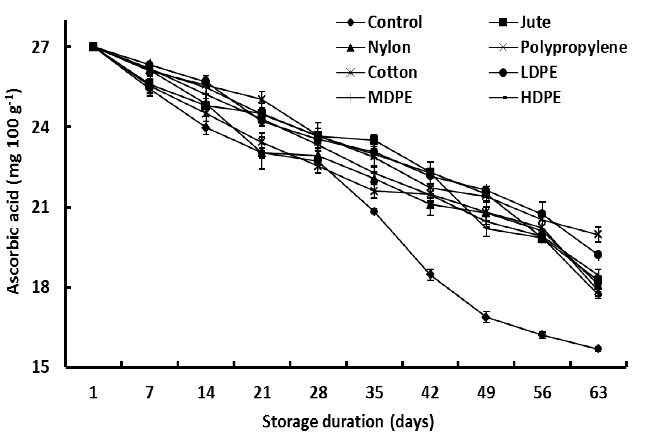
Fig. 3: Ascorbic acid content in potato tubers stored using different pa- ckaging materials was highest by the end of the storage period in polypropylene packages. Vertical bars show ±SE of means (n-3). Interaction between storage intervals and packaging materials was significantly different at p ≤ 0.05.